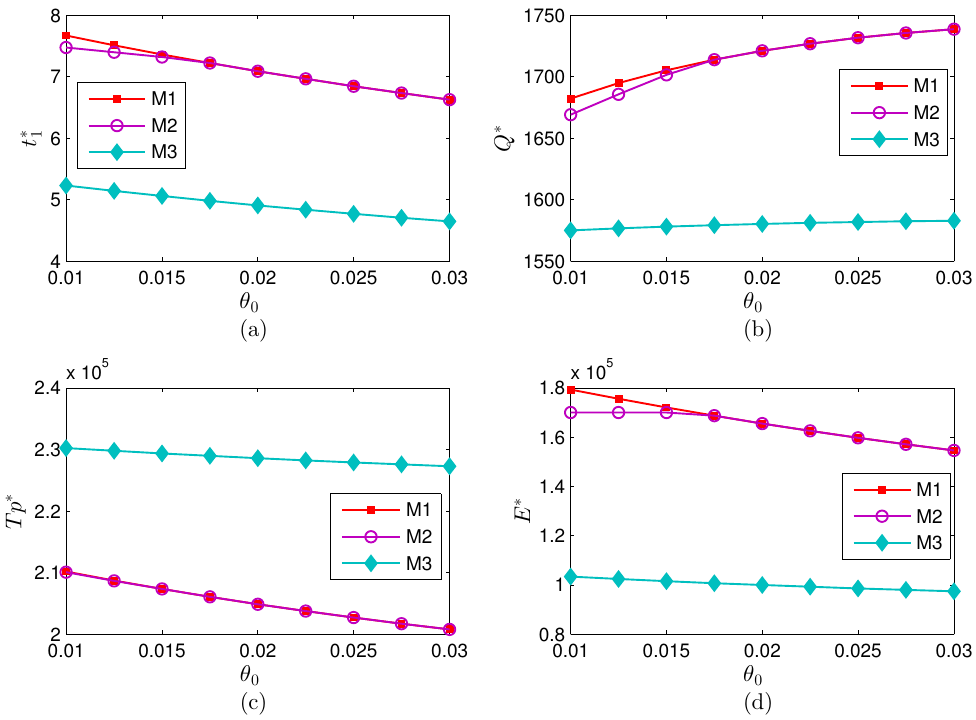
Figure 2. The impacts of the deterioration coefficient on the optimal inventory performance. ( a ) Comparison of the optimal time point with deterioration. ( b ) Comparison of the optimal order quantity with deterioration. ( c ) Comparison of the optimal total profit with deterioration. ( d ) Comparison of the optimal total carbon emissions with